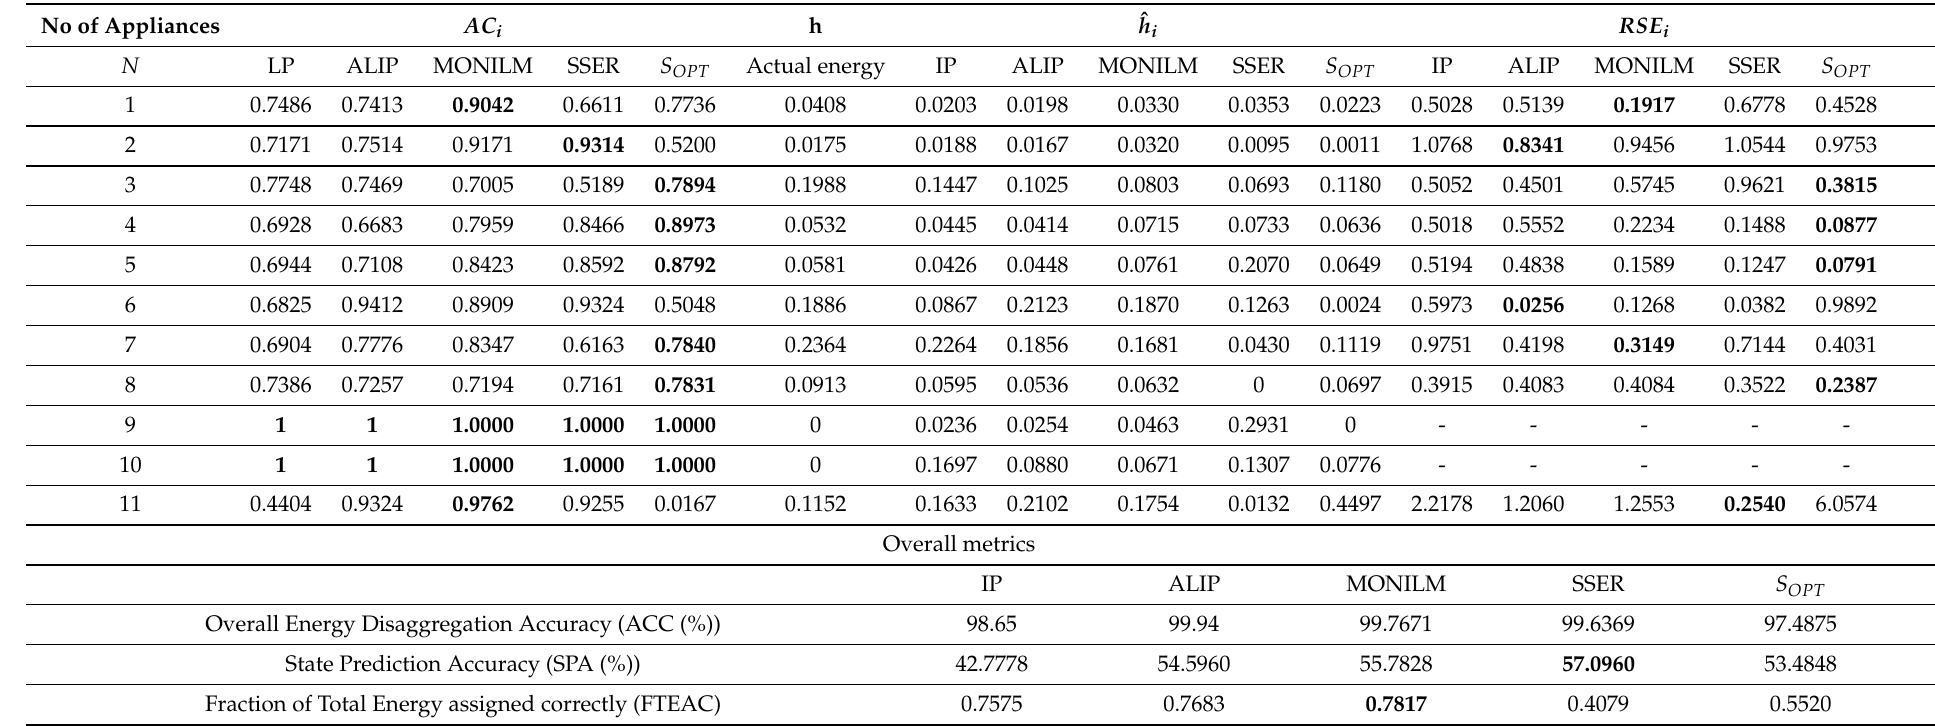
Table 4. Baseline results for instance I 2